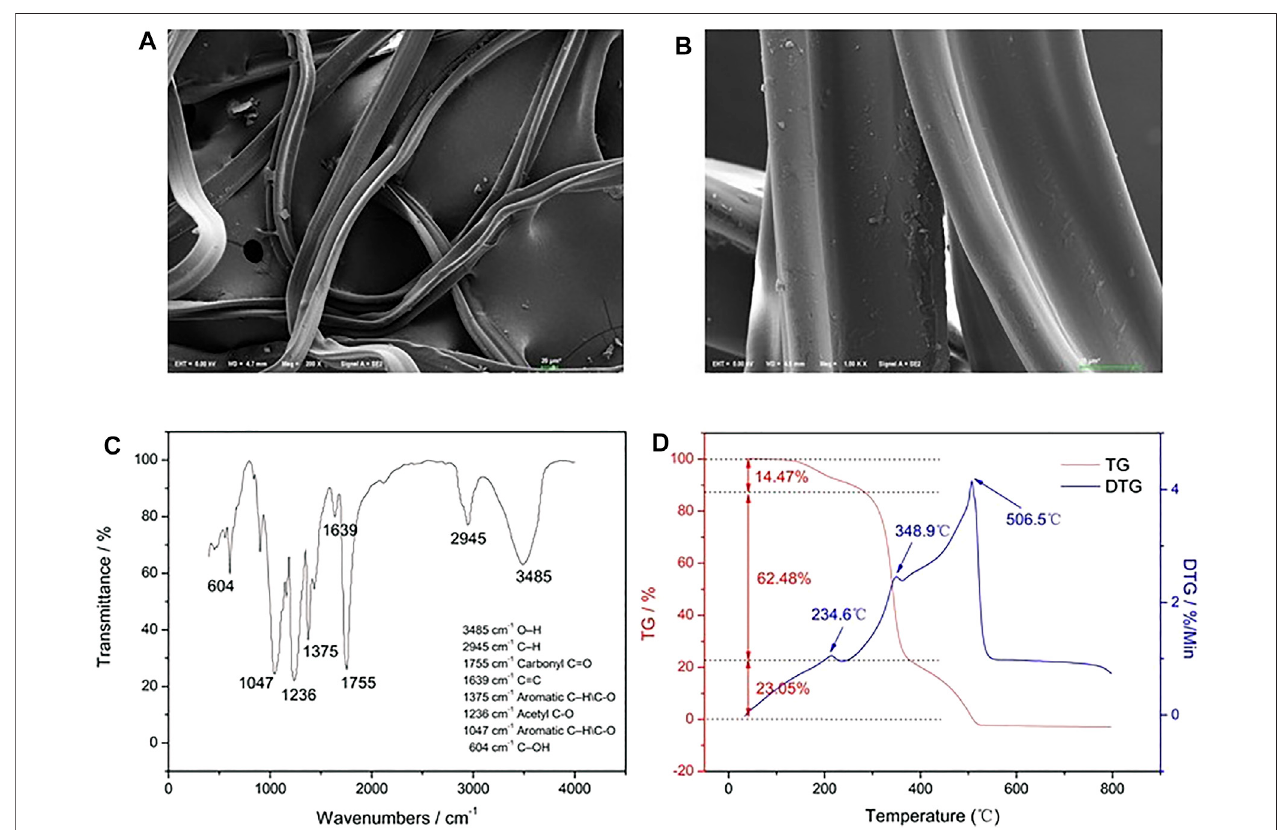
FIGURE 3 | Characterization for rCDA by (A) SEM image ( × 200), (B) SEM image ( × 1,500), (C) FTIR, and (D) TG-DTG.